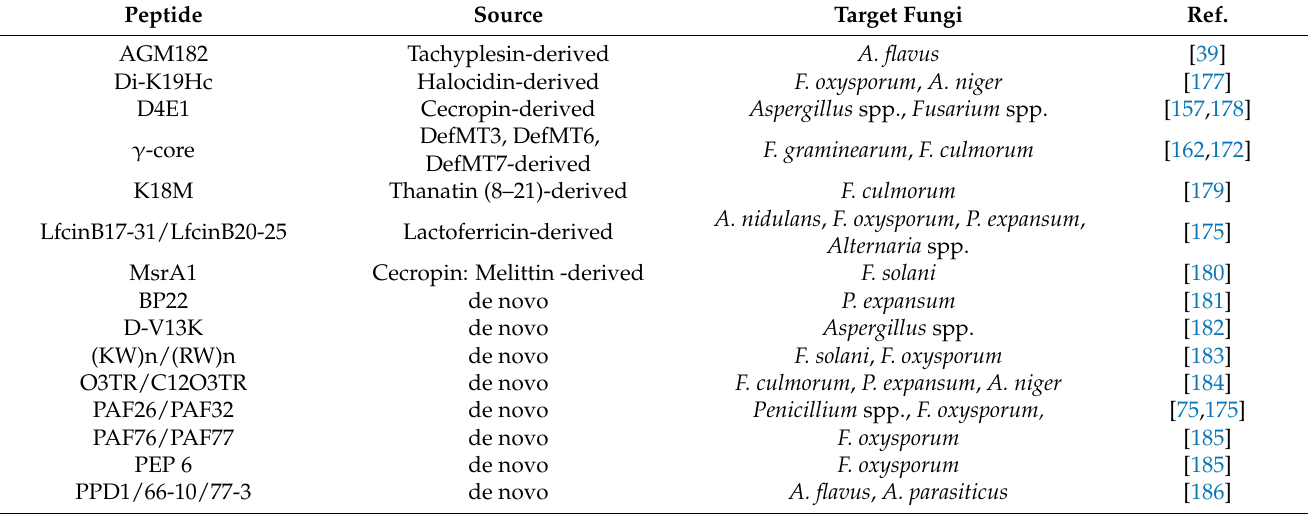
Table 4. Synthetic antifungal peptides with activity against mycotoxin-producing fungi. Source Target